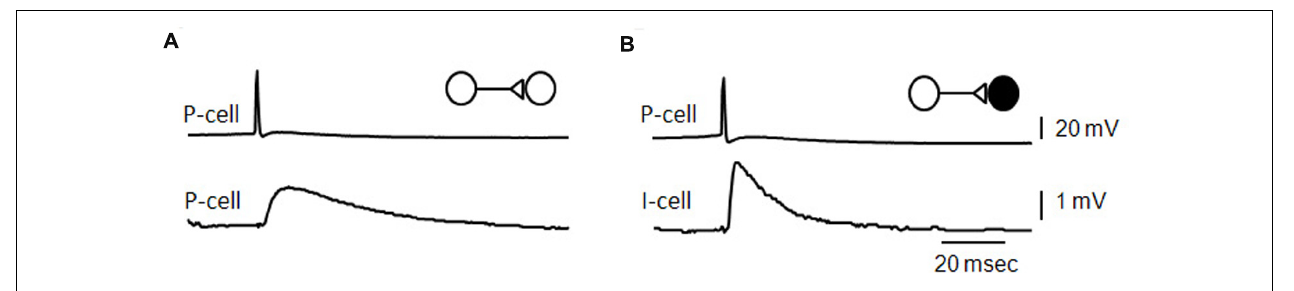
FIGURE 3 | Unitary effects of recurrent excitatory synapses. (A) Average of EPSPs initiated in a CA3 pyramidal cell by single action potentials in a pre-synaptic pyramidal cell (B) , average of